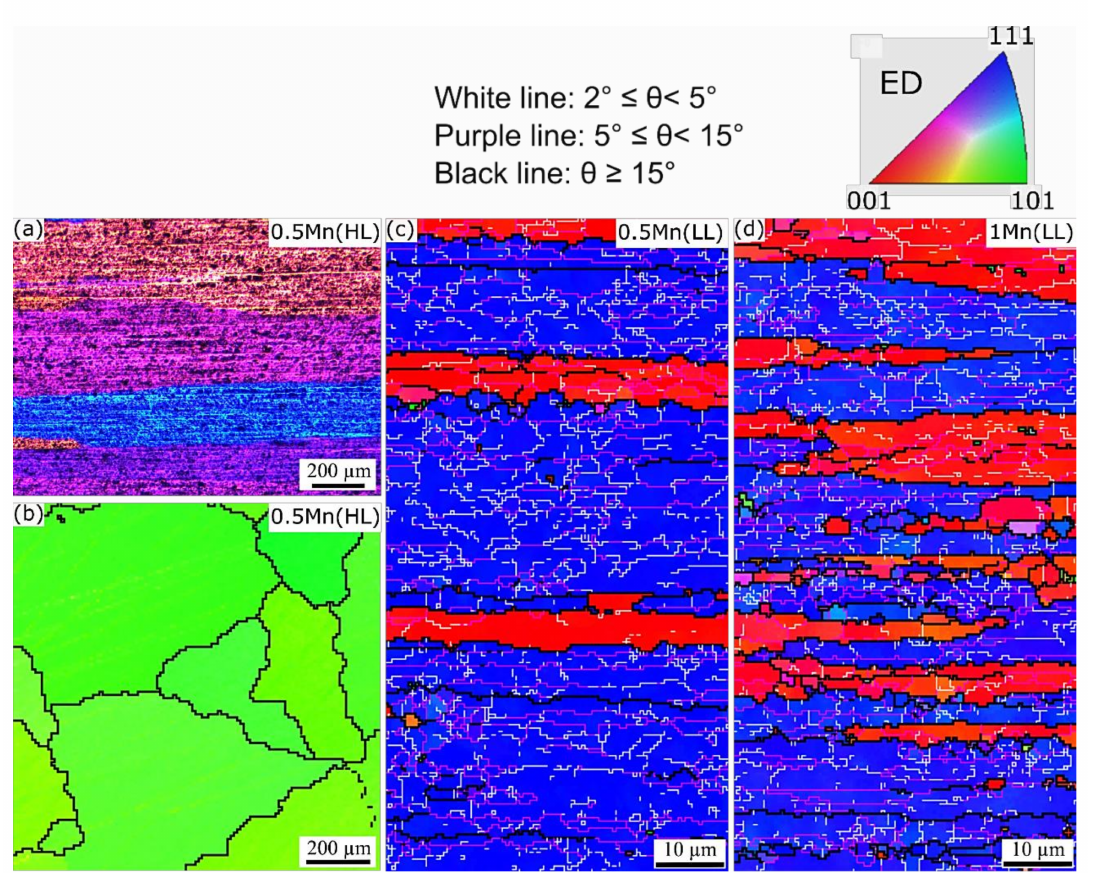
Figure 3. ( a ) Deformed grains from 0.5 Mn (HL) under optical microscopy and ( b – d ) the IPF maps acquired from solutionized alloys: ( b ) 0.5Mn(HL), ( c ) 0.5Mn(LL), and ( d ) 1Mn(LL), showing the grain/subgrain structures and the crystallographic orientations. Maps were obtained from the surface parallel ( a , c , d ) and perpendicular ( b ) to the extrusion